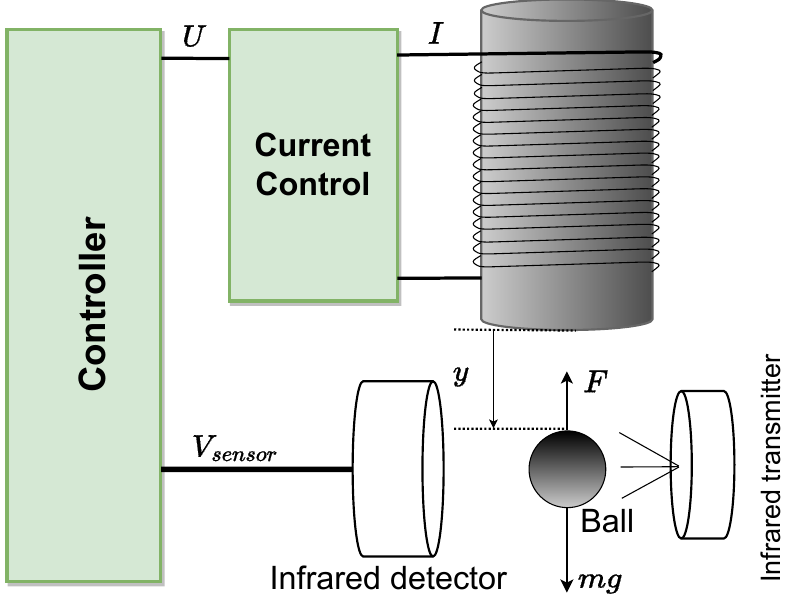
Figure 1. Magnetic levitation system